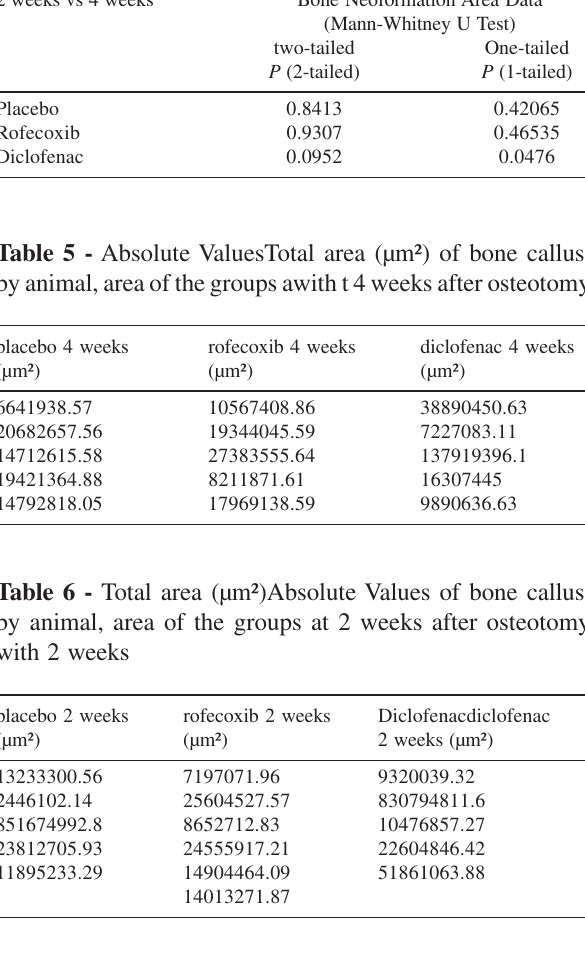
Table 7 - Total area (µm²) ofAbsolute Values of bone neoformation, by animal, area of the groups with 4 weeks after osteotomy